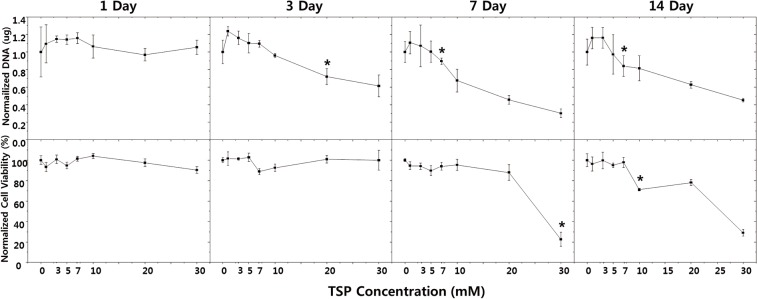
DNA amount and cell viability as a function of TSP concentration for each culture period.
DNA amounts at day 1 (a), day 3 (b), day 7 (c) and day 14 (d); cell-viability at day 1 (e), day 3 (f), day 7 (g) and day 14 (h). All values are normalized to TSP-zero values at each time point. (* p<0.05).